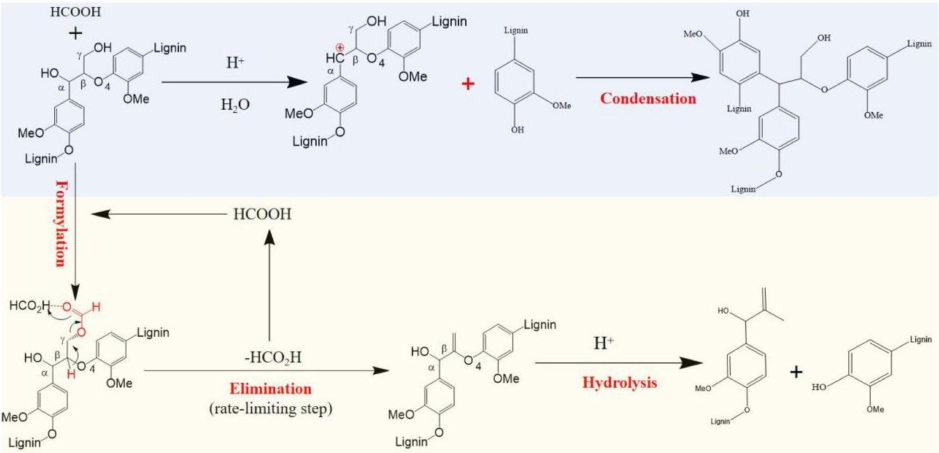
Figure 6. Proposed mechanism for the depolymerization and condensation of lignin during formosolv fractionation. Up: condensation scheme; Down: depolymerization